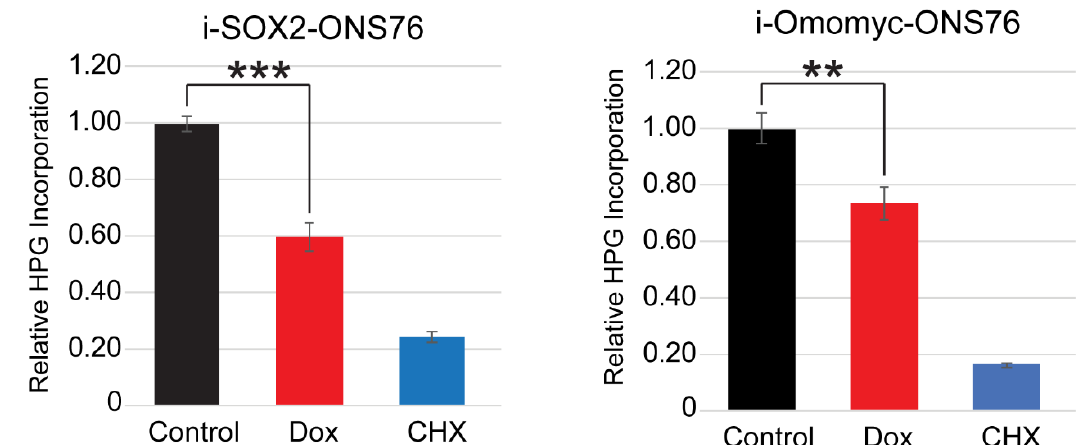
Figure 6. Elevating SOX2 and omomyc downregulates protein translation in ONS76 cells. Protein translation in i-SOX2-ONS76 and i-Omomyc-ONS76 cells was quantified by the flow cytometry analysis of HPG incorporation after 48 h culture in the presence of the indicated doses of Dox. Error bars represent standard deviations. ** p < 0.01, *** p < 0.001.